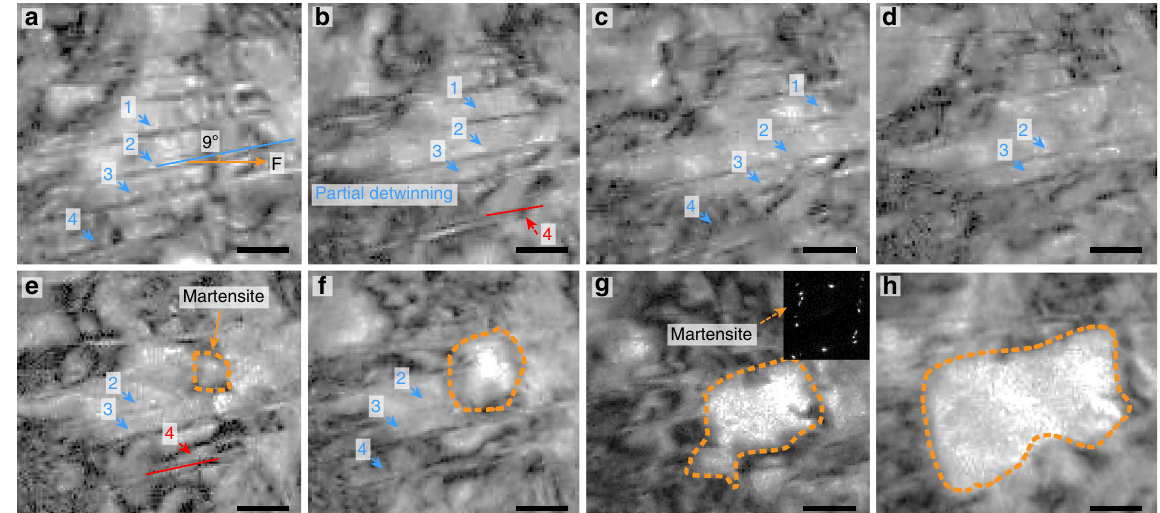
Fig. 2 Detwinning and martensitic transformation of the NTs. a The starting microstructure of the primary NTs with a 9° TB orientation angle to the tensile direction. The blue arrows (Arrows 1 – 4) illustrate the detwinning positions and the red Line 4 and Arrow 4 indicate the twinning positions in b and e . a – f show the detwinning of NTs 1 – 4. e – h indicate the nucleation and growth of the martensite phase, as marked by orange dotted circles in e – h . The inset in g is the SAED pattern of the newly-formed martensite phase, as indicated by the orange dotted arrow. The standard deviation of λ is 0.5nm. F is the external tensile load. The time frames of a – h are 0, 10, 17, 22, 37, 42, 63, and 69s, respectively. All scale bars are 20nm